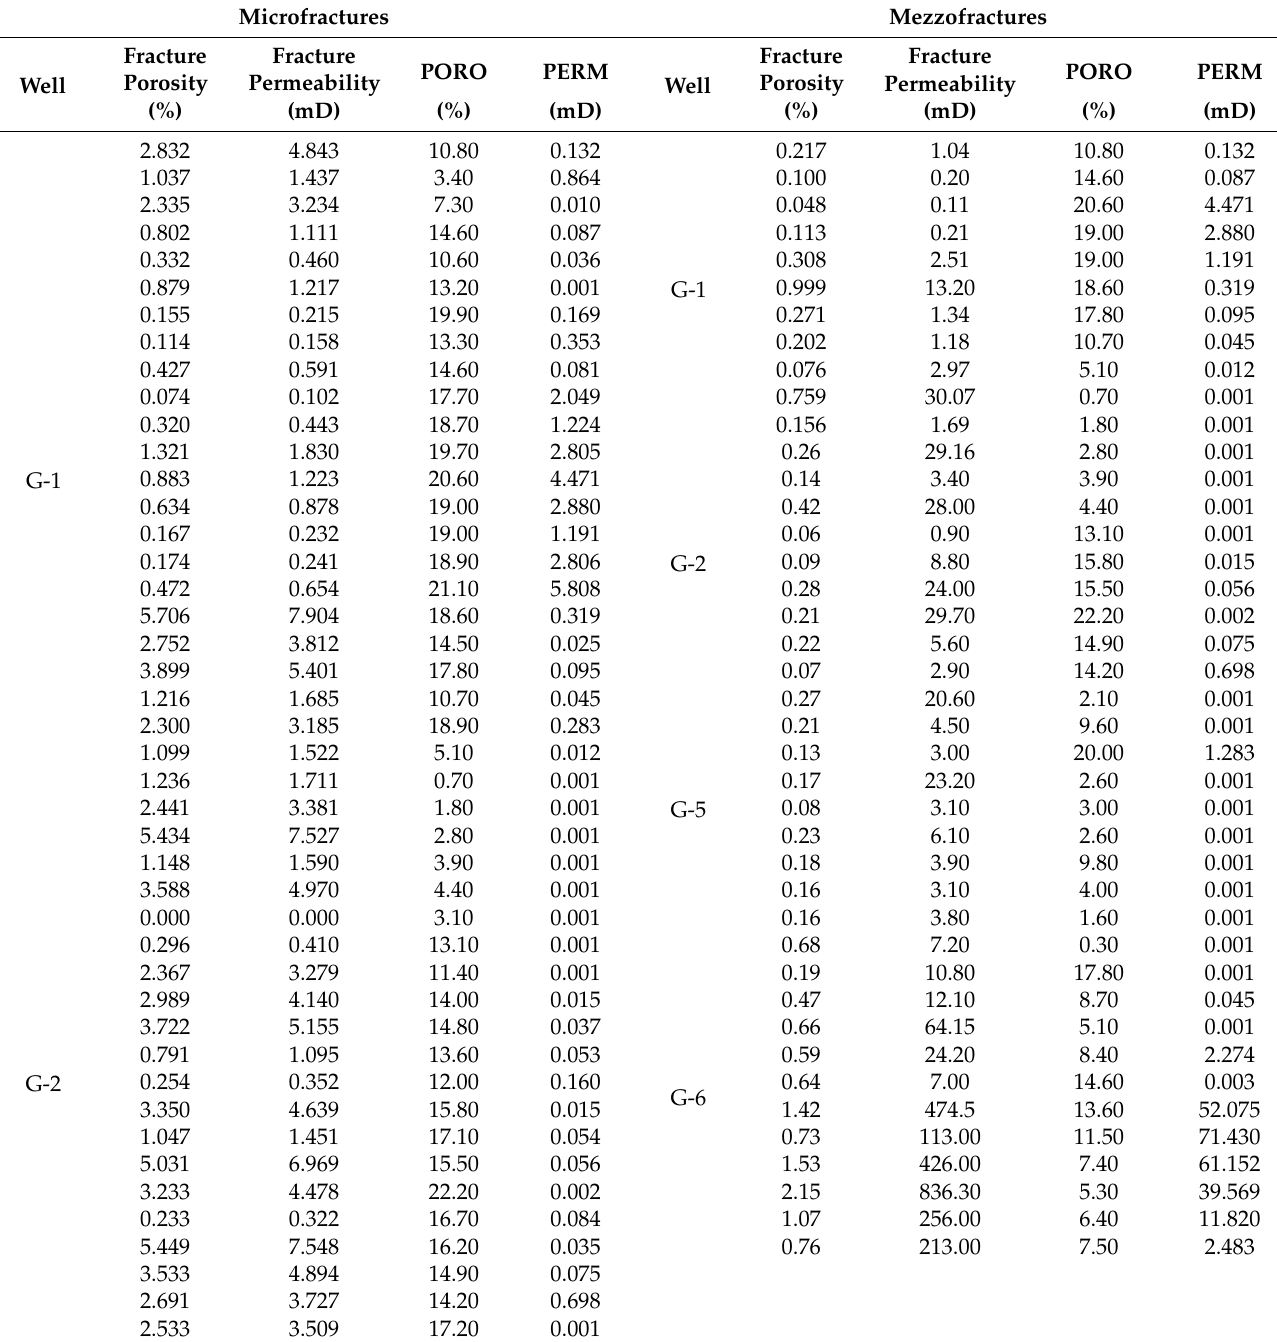
Table 3. Fracture porosity and fracture permeability obtained from the thin section analyses of micro- and mezzofractures and porosity (PORO) and permeability (PERM) from well logging interpretation (boreholes G-1, G-2, G-5 and G-6 in the study area). Microfractures Mezzofractures Fracture Fracture PORO PERM PORO PERM Porosity Well Porosity Well